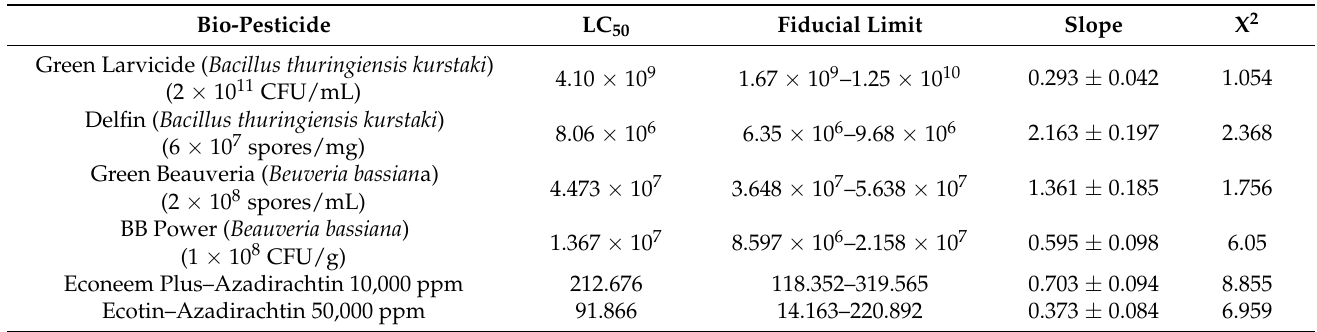
Table 3. Toxicity of bio-pesticides to Tuta absoluta larvae ( n = 100